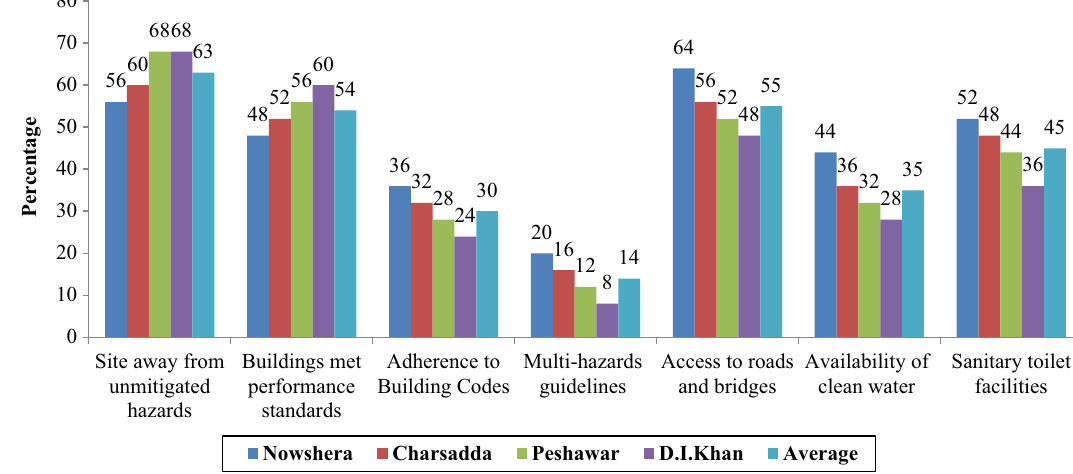
Fig. 5 School sites and building design for safety of Khyber Pakhtunkhwa’s schools, 2010–2017